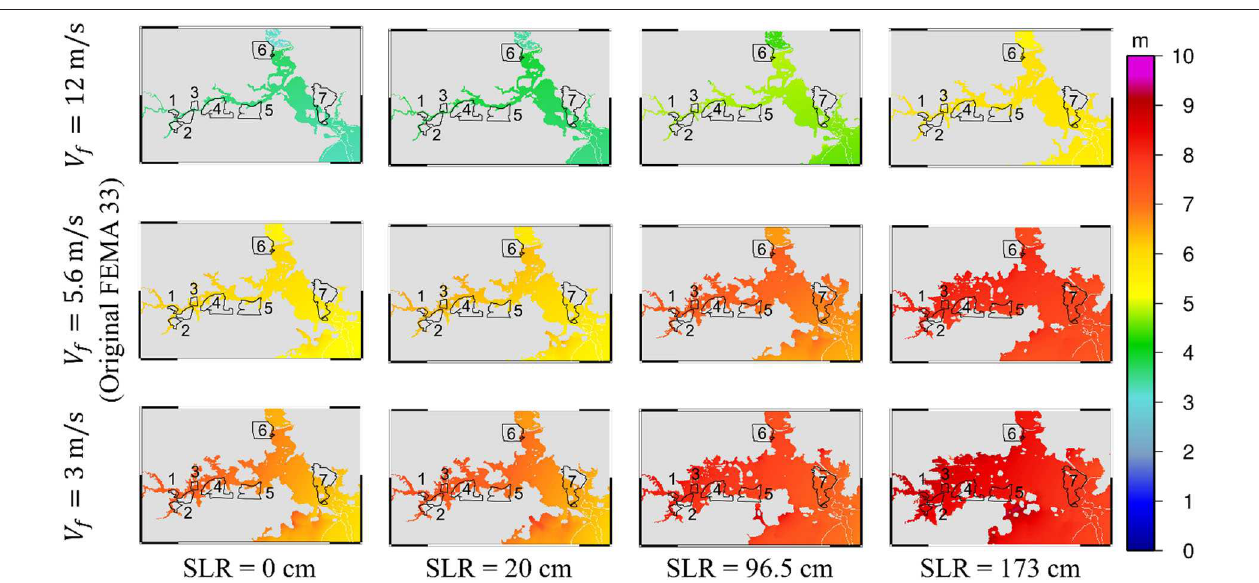
FIGURE 6 | Effect of SLR and (select) forward speeds on the maximum water elevations of FEMA 33 in the HSC and the target